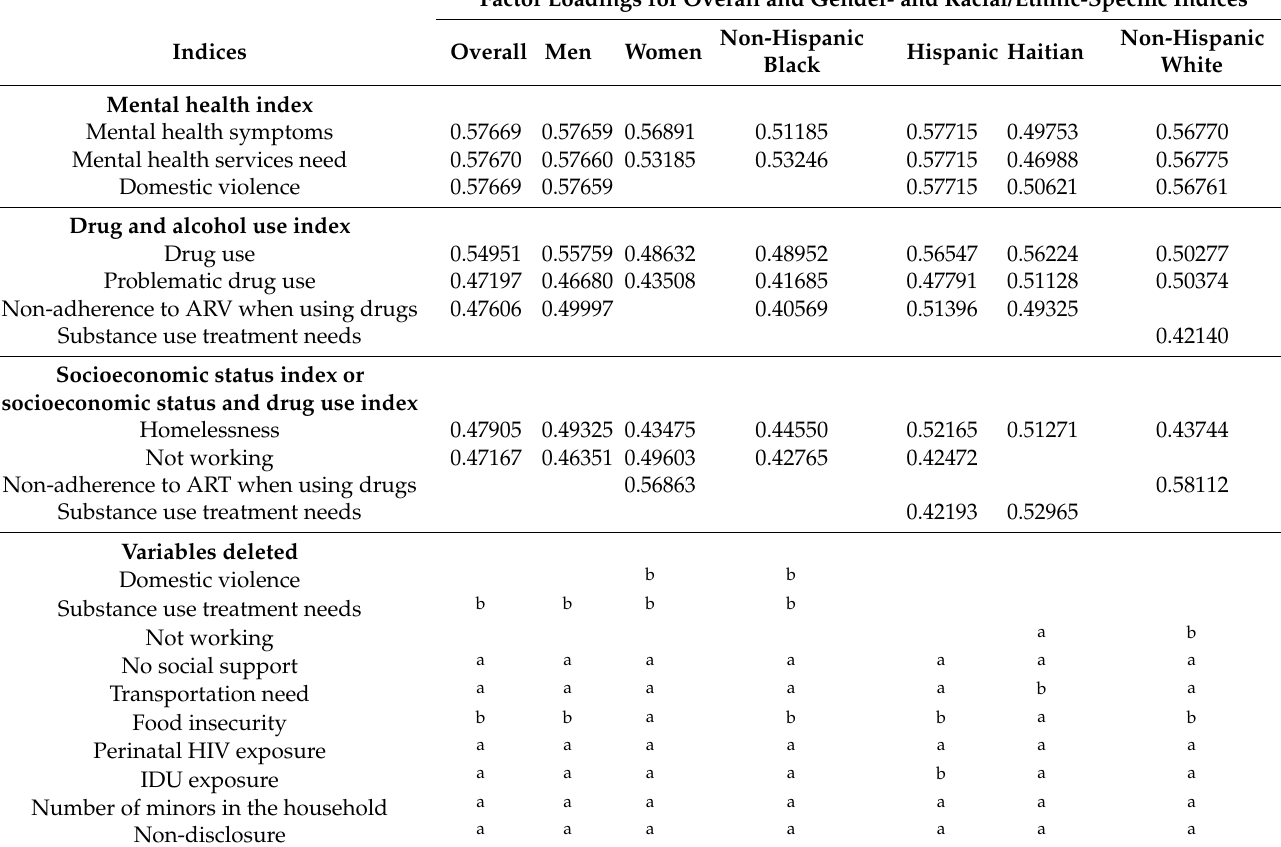
Table 1. Variables included in vulnerable/enabling indices and factor loadings from principal component analysis for overall indices and gender- and racial/ethnic-specific indices among Miami–Dade County Ryan White Program clients. Factor Loadings for Overall and Gender- and Racial/Ethnic-Specific